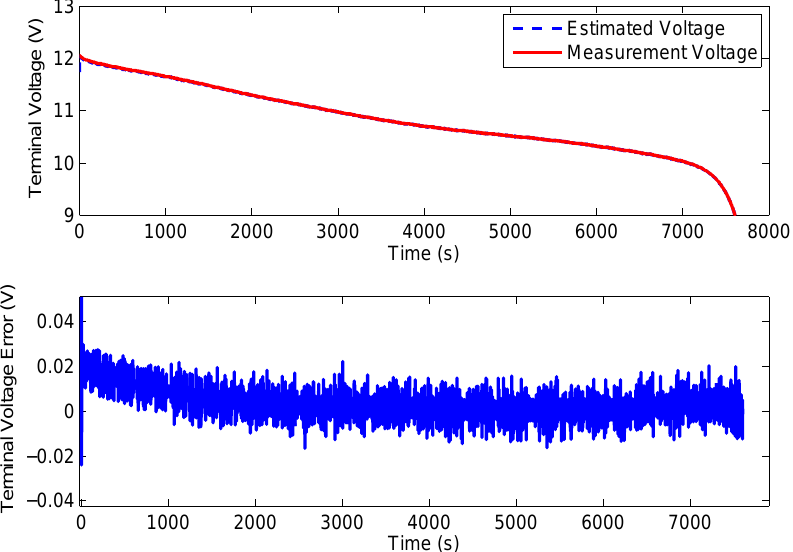
Figure 5. Experimental terminal voltage results using VB-ADEKF in the constant current discharge test.